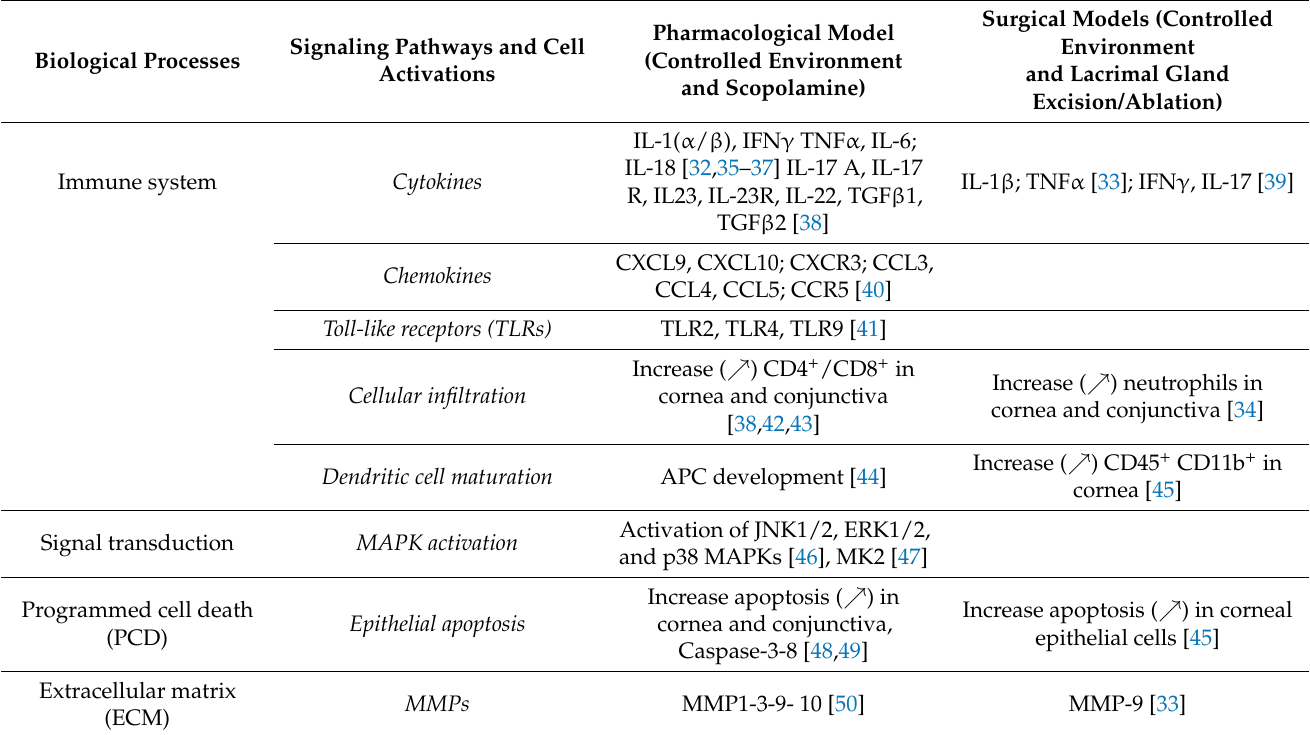
Table 2. Summary of current biological processes and molecular mediators involved in two experimental dry eye mouse